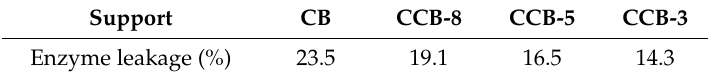
Table 1. Enzyme leakage from various